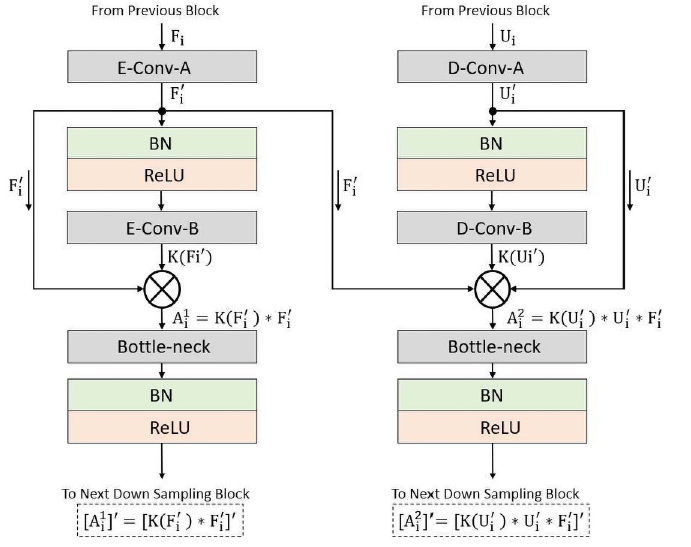
Fig 2. Connectivity principle of